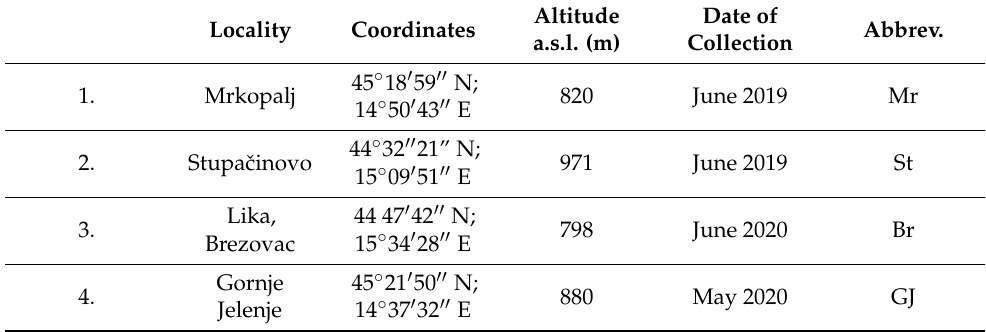
Table 5. Locations of the plant material collection (for volatile compounds